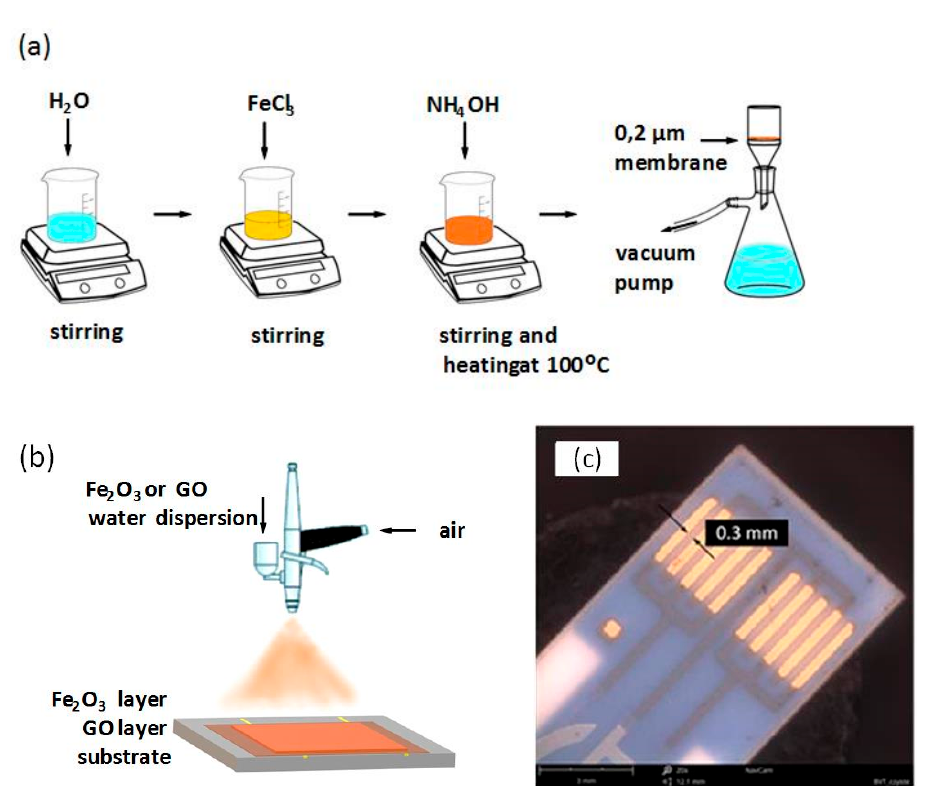
Figure 1. ( a ) Illustration of the manufacturing process of α -Fe 2 O 3 , ( b ) preparation of GO/ α -Fe 2 O 3 multilayer by the spraying method, and ( c ) outlook of the ceramic substrate used for deposition of the multilayer for electrical measurements.